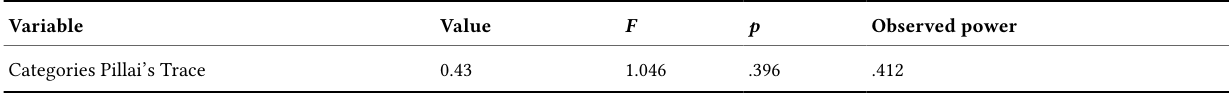
Multivariate Analysis of Variance (MANOVA) Between Categories of Exercise Dependence and Areas of Body Esteem for Female Gym-Goers Variable Value F